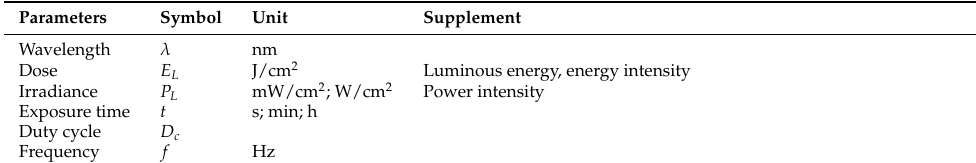
Table 4. The parameters of blue